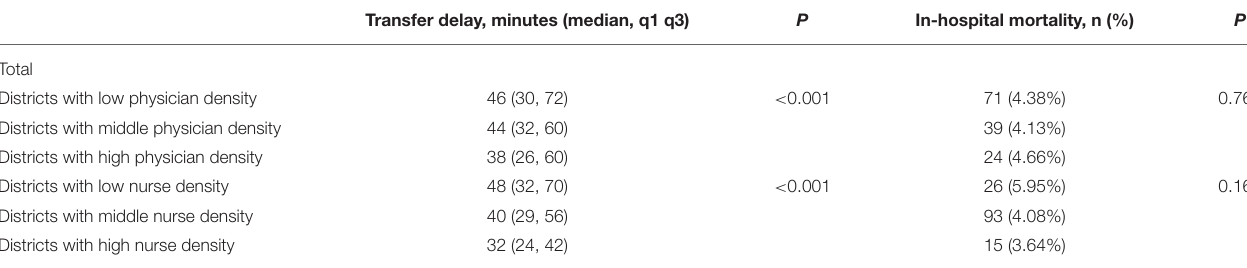
TABLE 3 | Healthcare professionals at district level and transfer delay and in-hospital mortality of STEMI